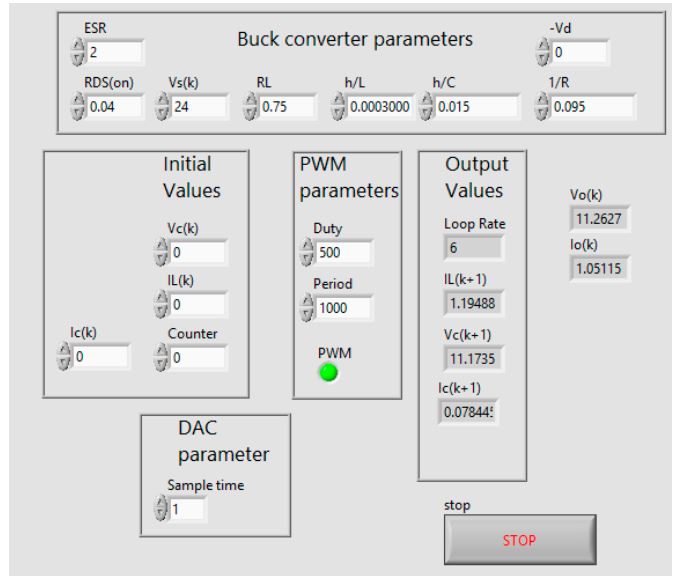
Figure 13. Front panel of the real-time simulation.